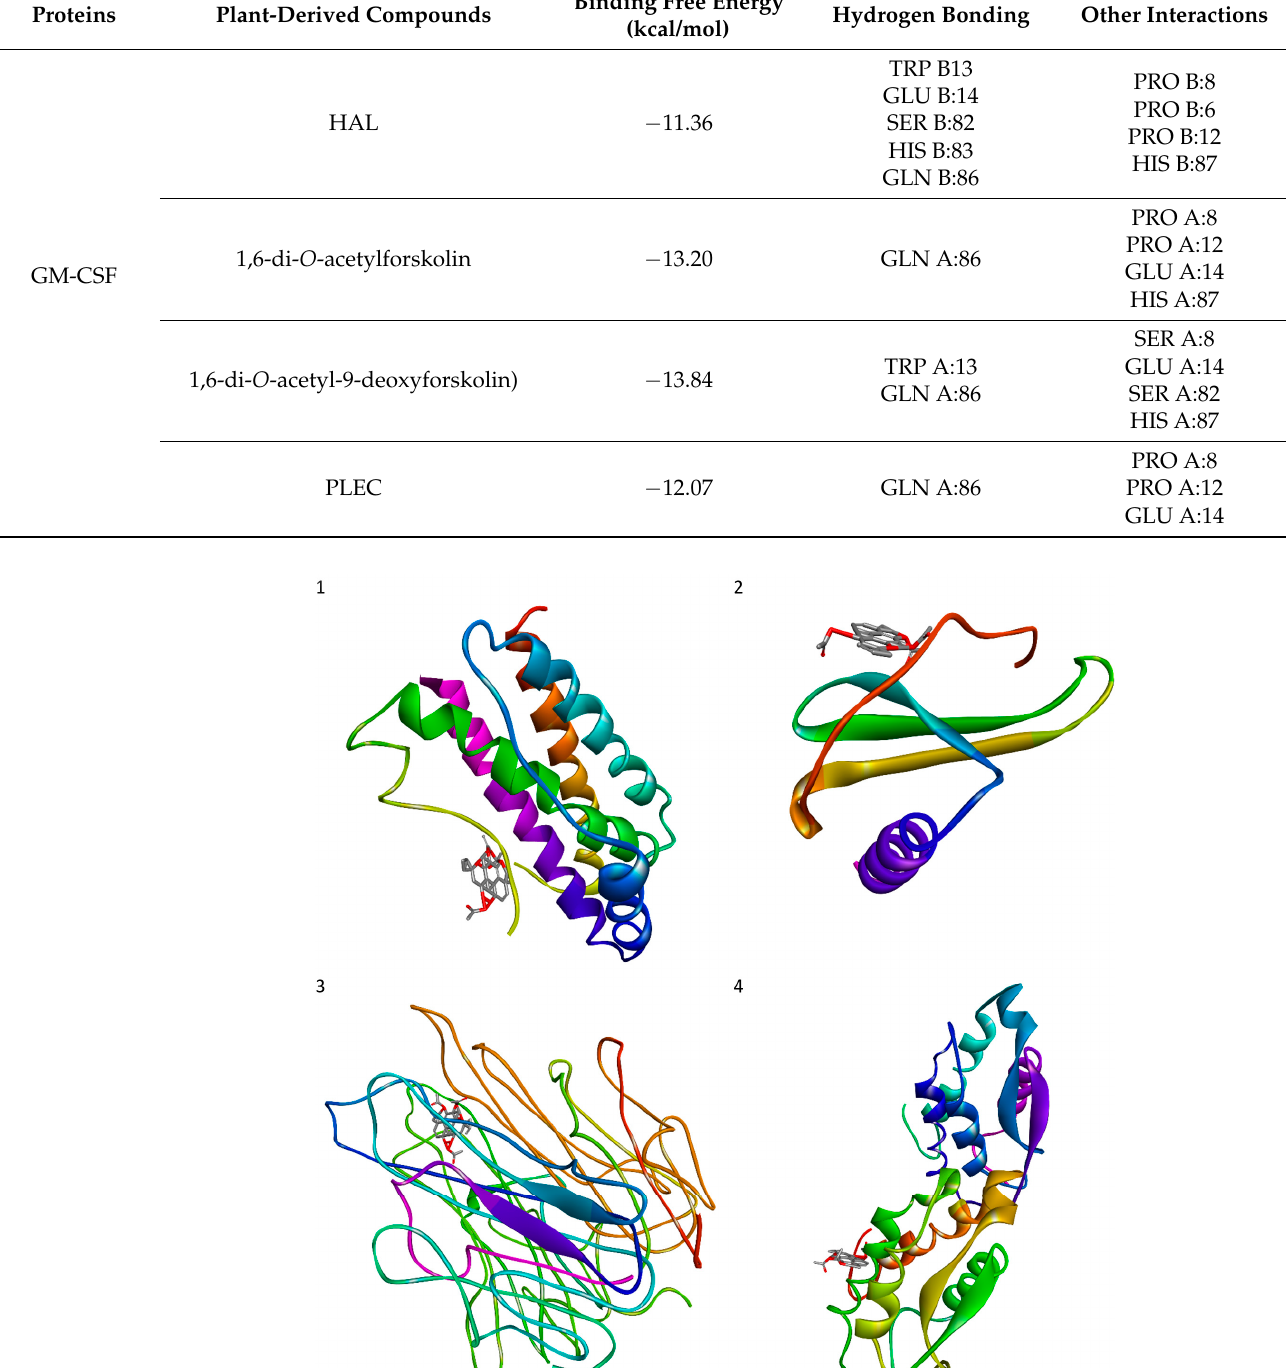
GM-CSF Proteins Plant-Derived Compounds